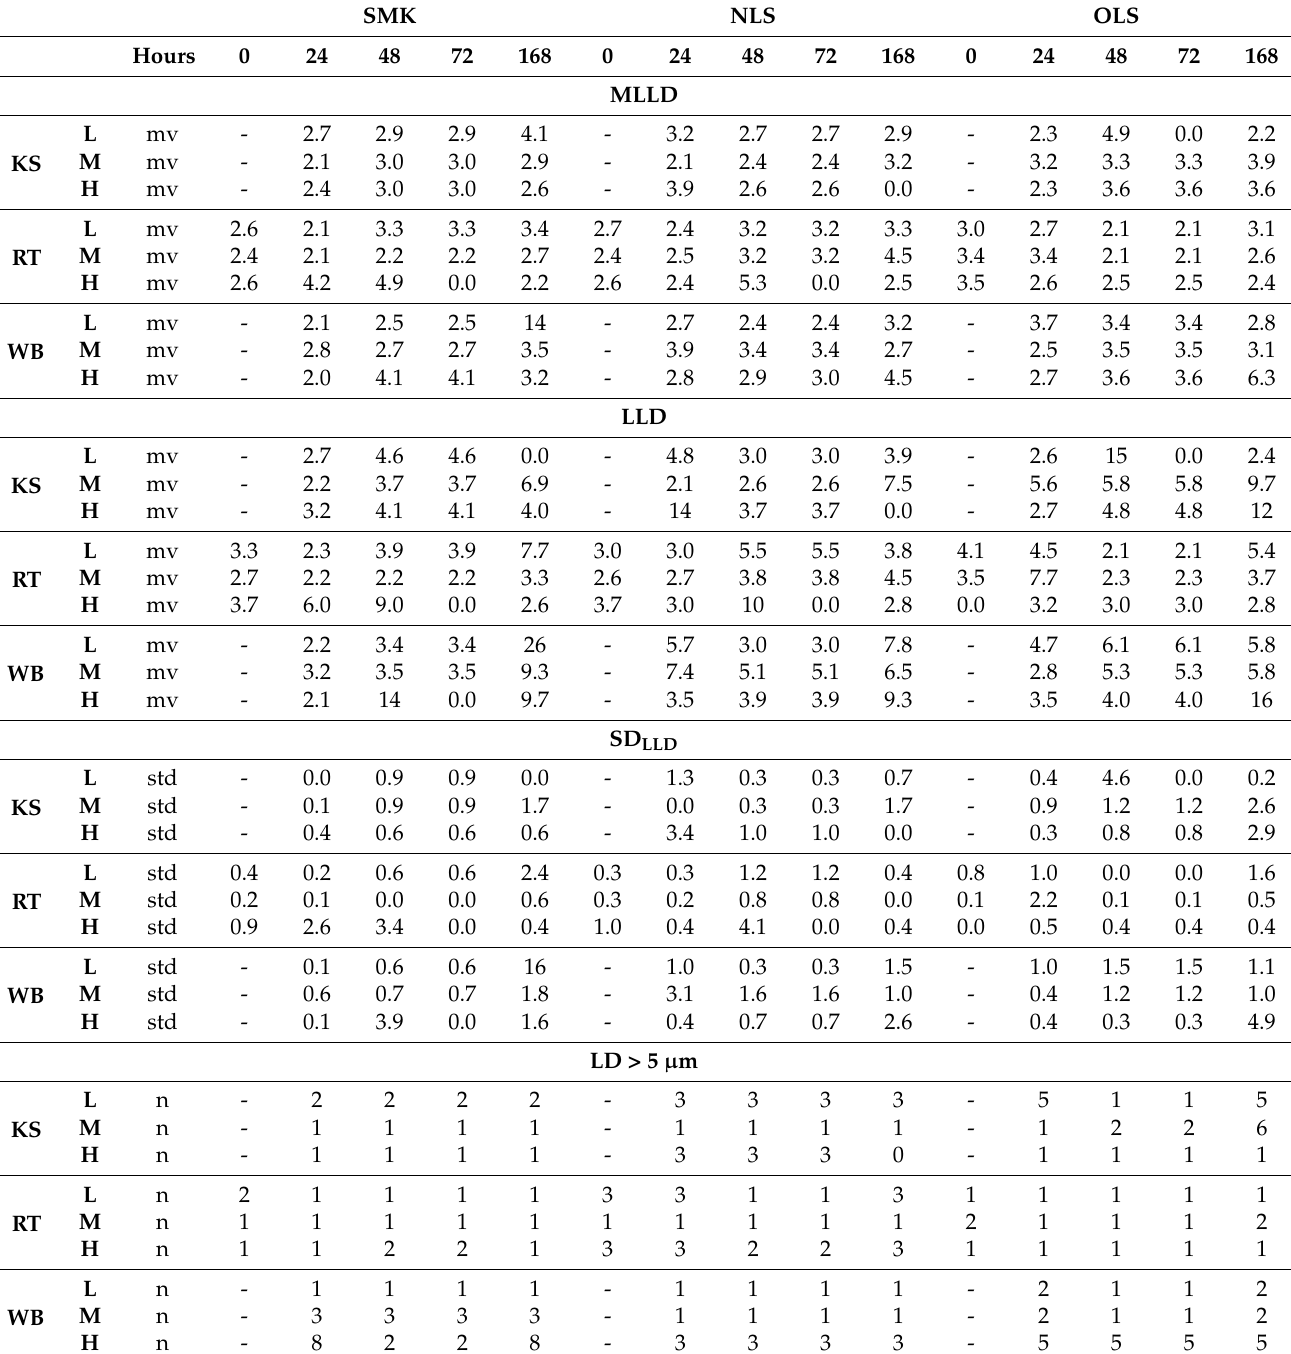
Table 5. Results of the automated microscopic photo analysis (size in µ m and counts). SMK NLS